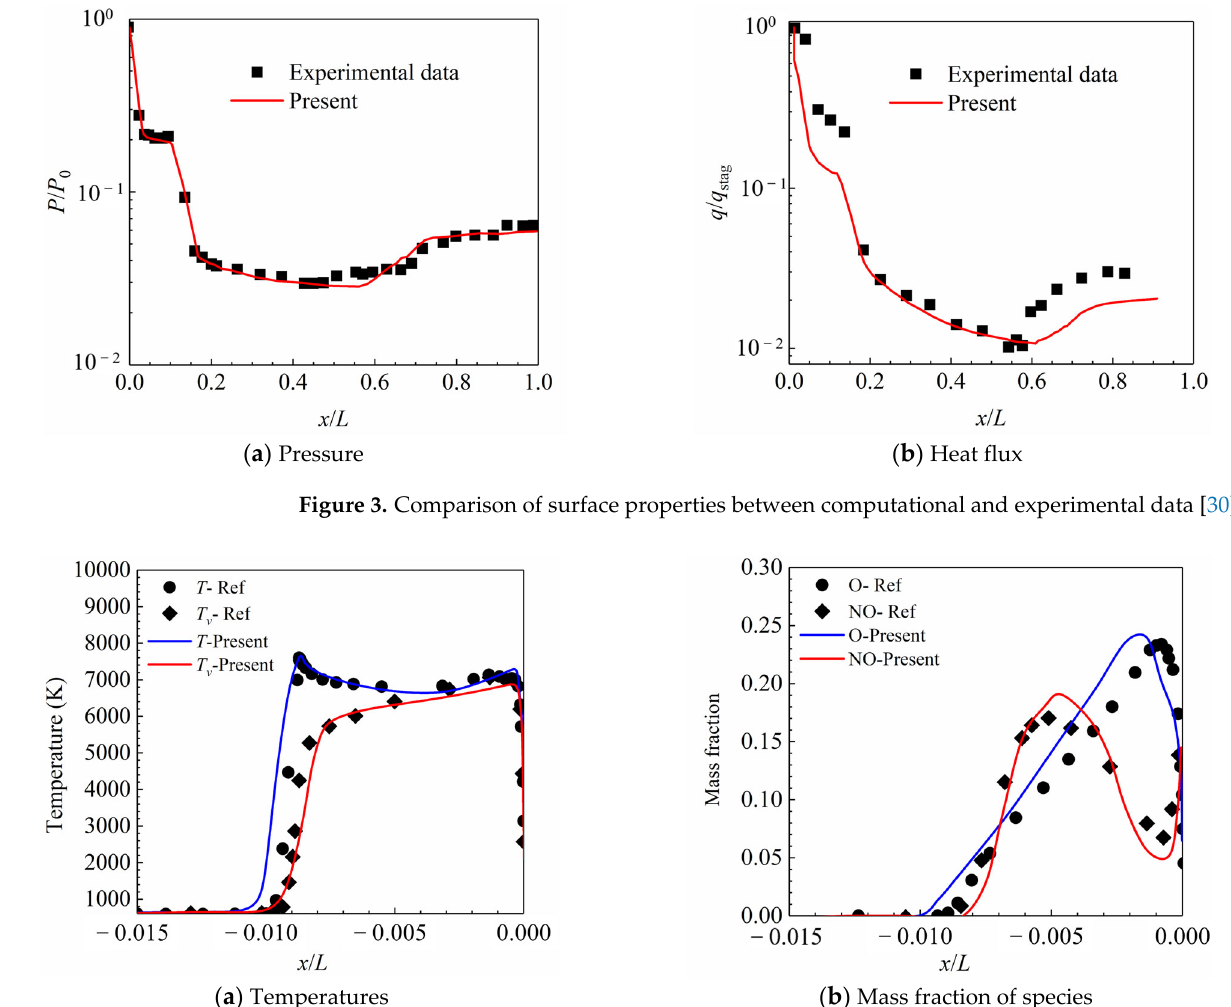
Figure 4. Comparison of flow parameters along the stagnation line between computational and reference data [31].